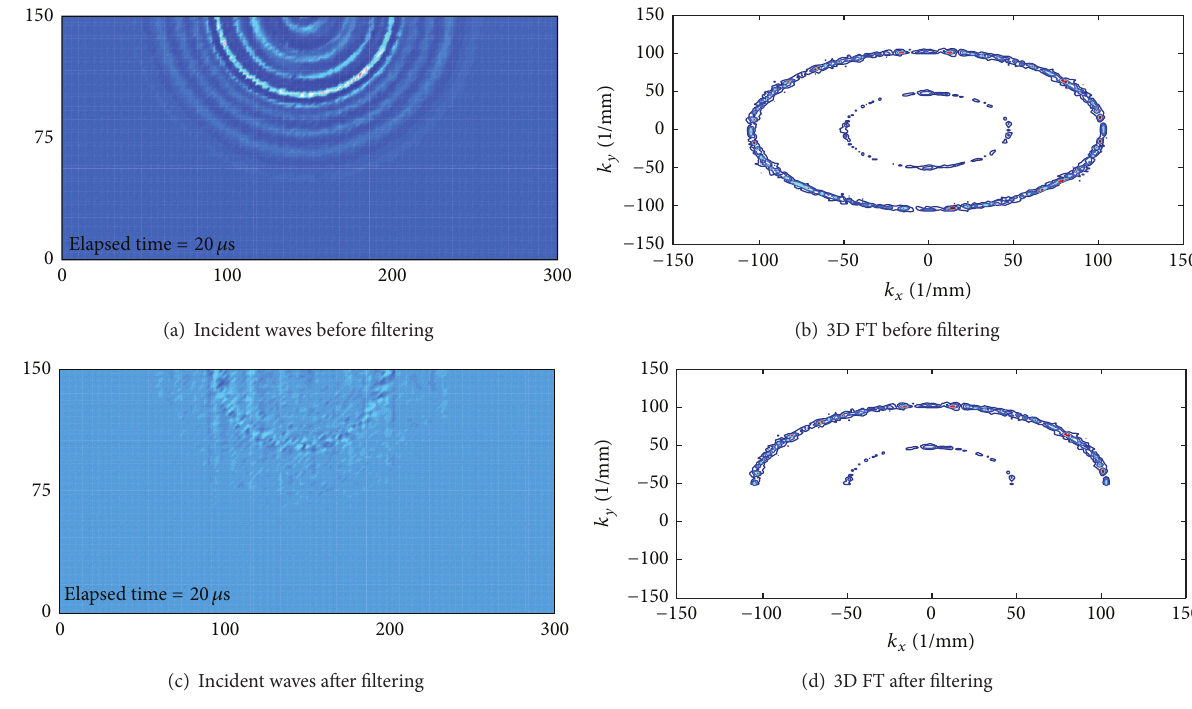
Figure 6: Elimination of downward incident waves by wavenumber filtering.